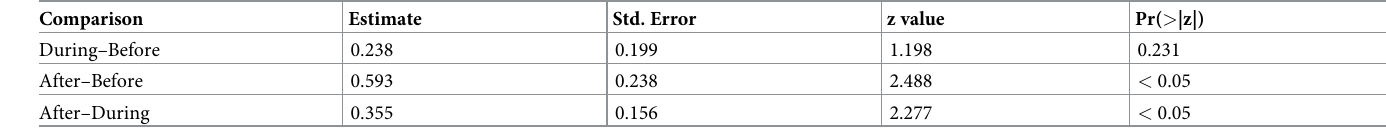
Table 2. Results of Tukey post hoc tests for multiple comparisons of fETE means for the different road construction phases.